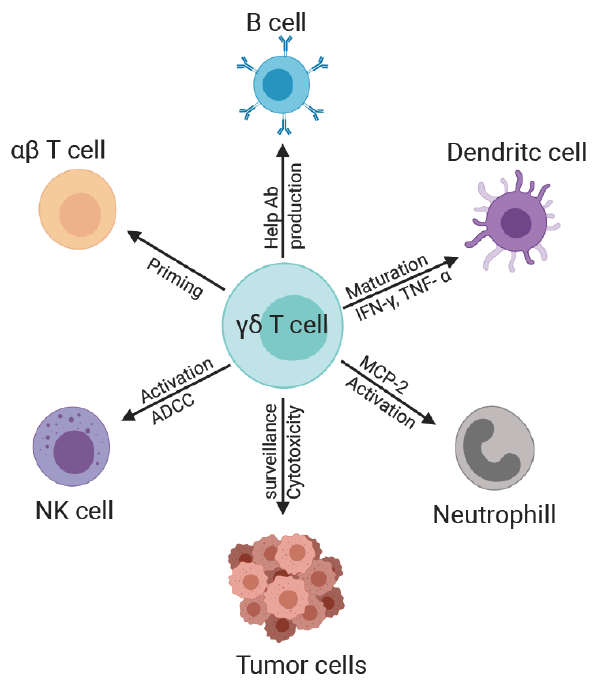
Figure 2. Crosstalk of γδ T cells with other immune cells. Dendritic cell: Activated γδ T cells secrete IFN- γ and TNF- α , which promote upregulation of CD86 and MHC class I molecules on DCs and increase DC secretion of IL-12p70. B cell: γδ T cells secrete IL-4, IL-10, and CXCL13, providing help to B cells for antibody production. Neutrophil: γδ T cells secrete IL-17A and CXCL8, which recruit neutrophils to inflammatory sites. NK cell: γδ T cells provide NK cells with the costimulatory signal CD137L to promote their activation and enhanced cytolytic activity. αβ T cell: Activated γδ T cells can process soluble antigens and present them in the context of both MHC class I and Class II molecules to naïve CD8+ and CD4+ αβ T cells respectively, to drive their proliferation, and differentiation. Tumor cells: γδ T cells can provide immunosurveillance and direct cytotoxicity of tumor cells.